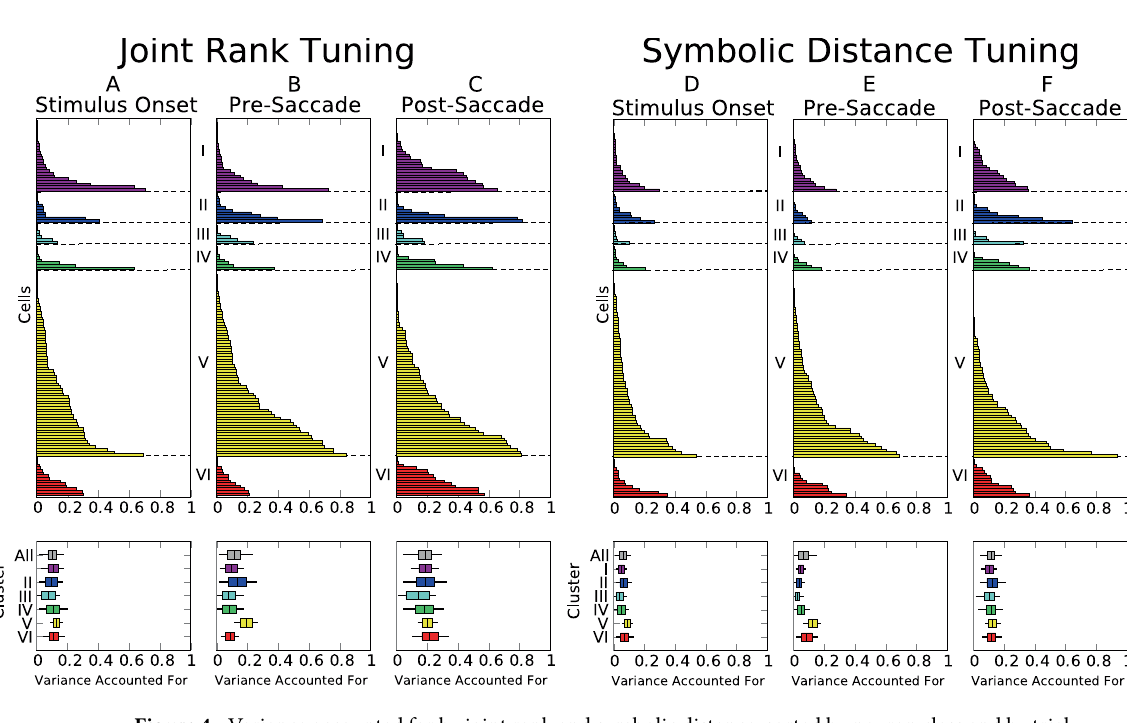
Trials in which only a single stimulus appeared (i.e. the first 5 blocks of each session) were sorted according to the identity of that stimulus. Figure 6A shows the values of z FR ( ) for the best and worst stimuli for each recording. Some degree of apparent stimulus preference can arise by chance, given finite sampling of variable neural